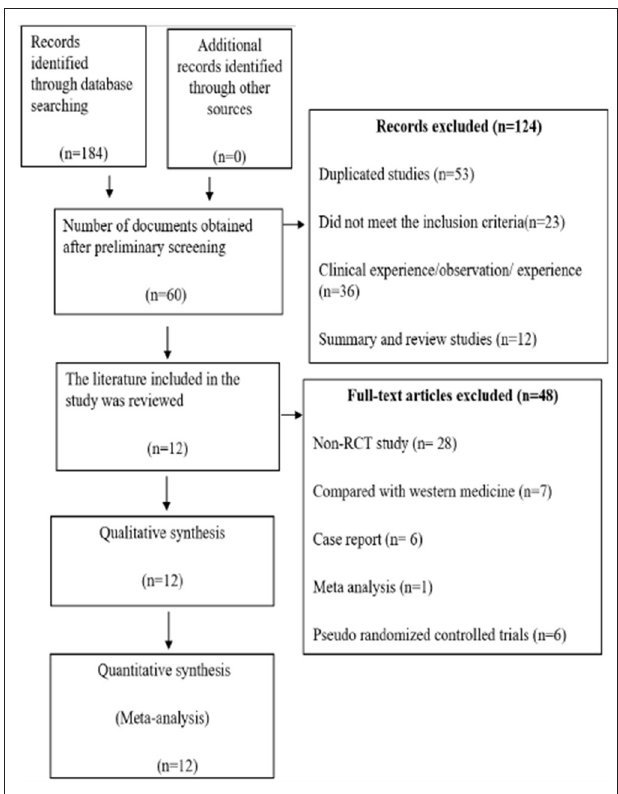
FIGURE 1 | Preferred reporting items for systematic reviews and meta-analysis (PRISMA) search